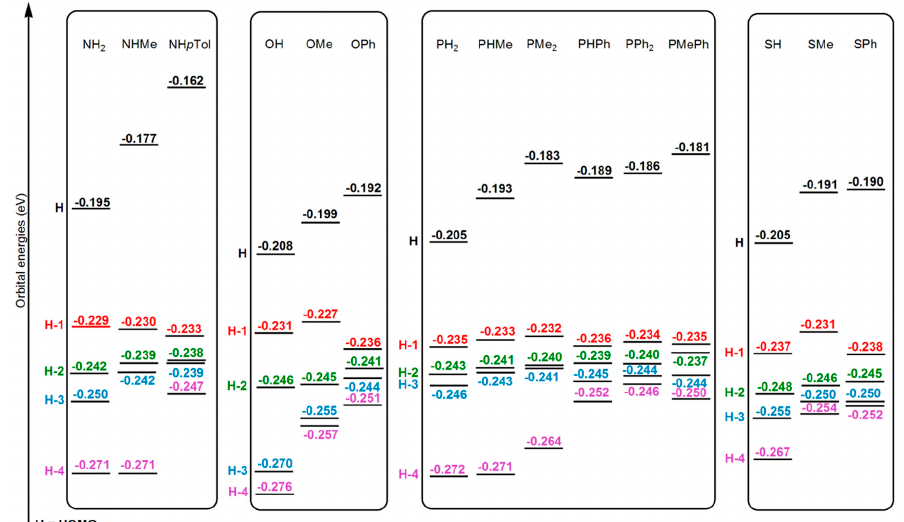
Figure 2. Energies (in eV) of the five highest occupied orbitals in the reactant complexes [ReY(CO) 3 (bipy)] (Y = NH 2 , NHMe, NH p Tol, OH, OMe, OPh, PH 2 , PHMe, PMe 2 , PHPh, PPh 2 , PMePh, SH, SMe, SPh).